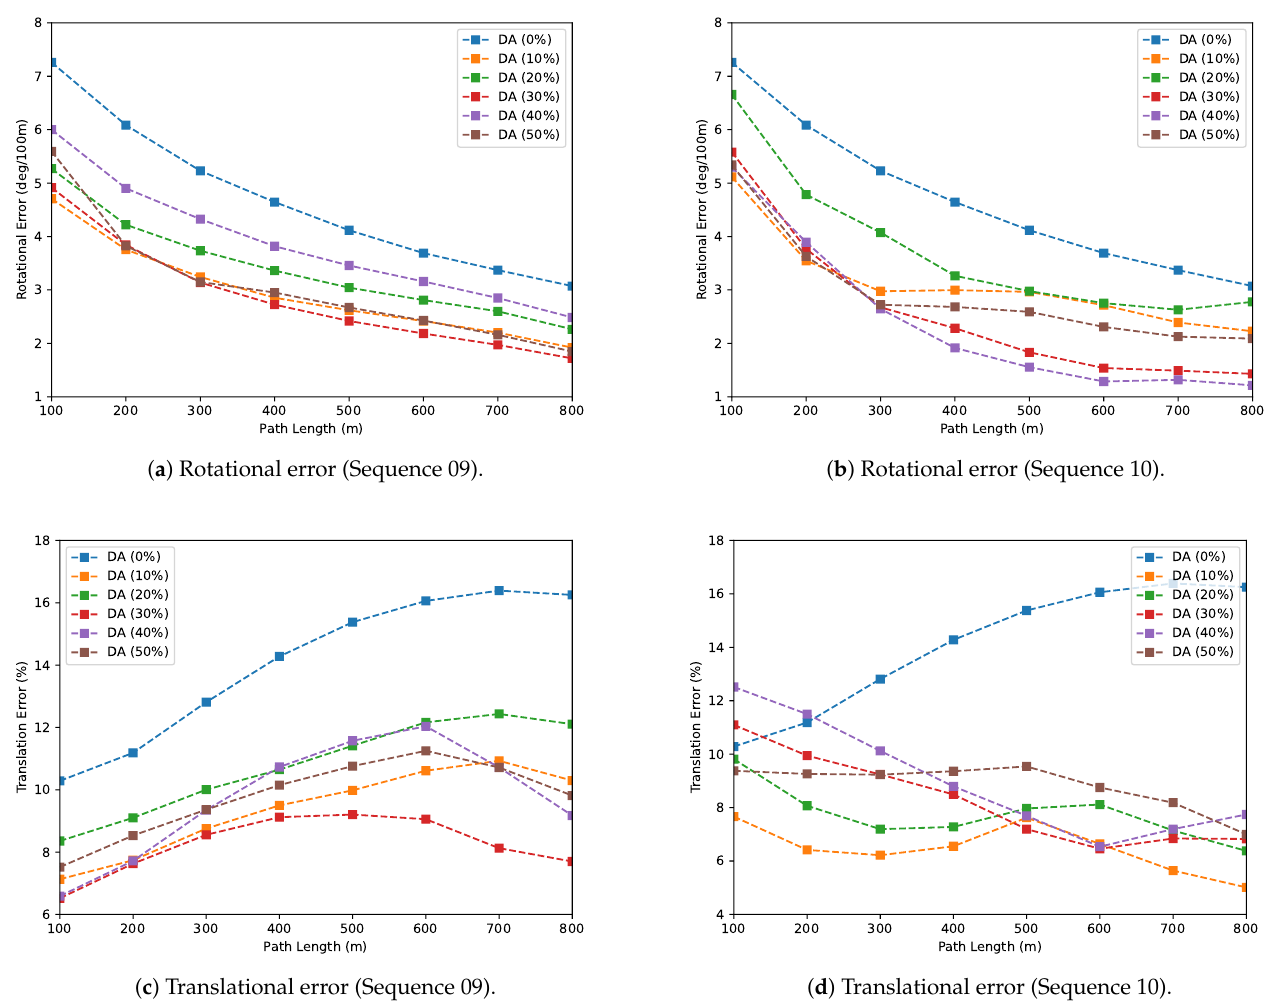
( d ) Translational error (Sequence 10).